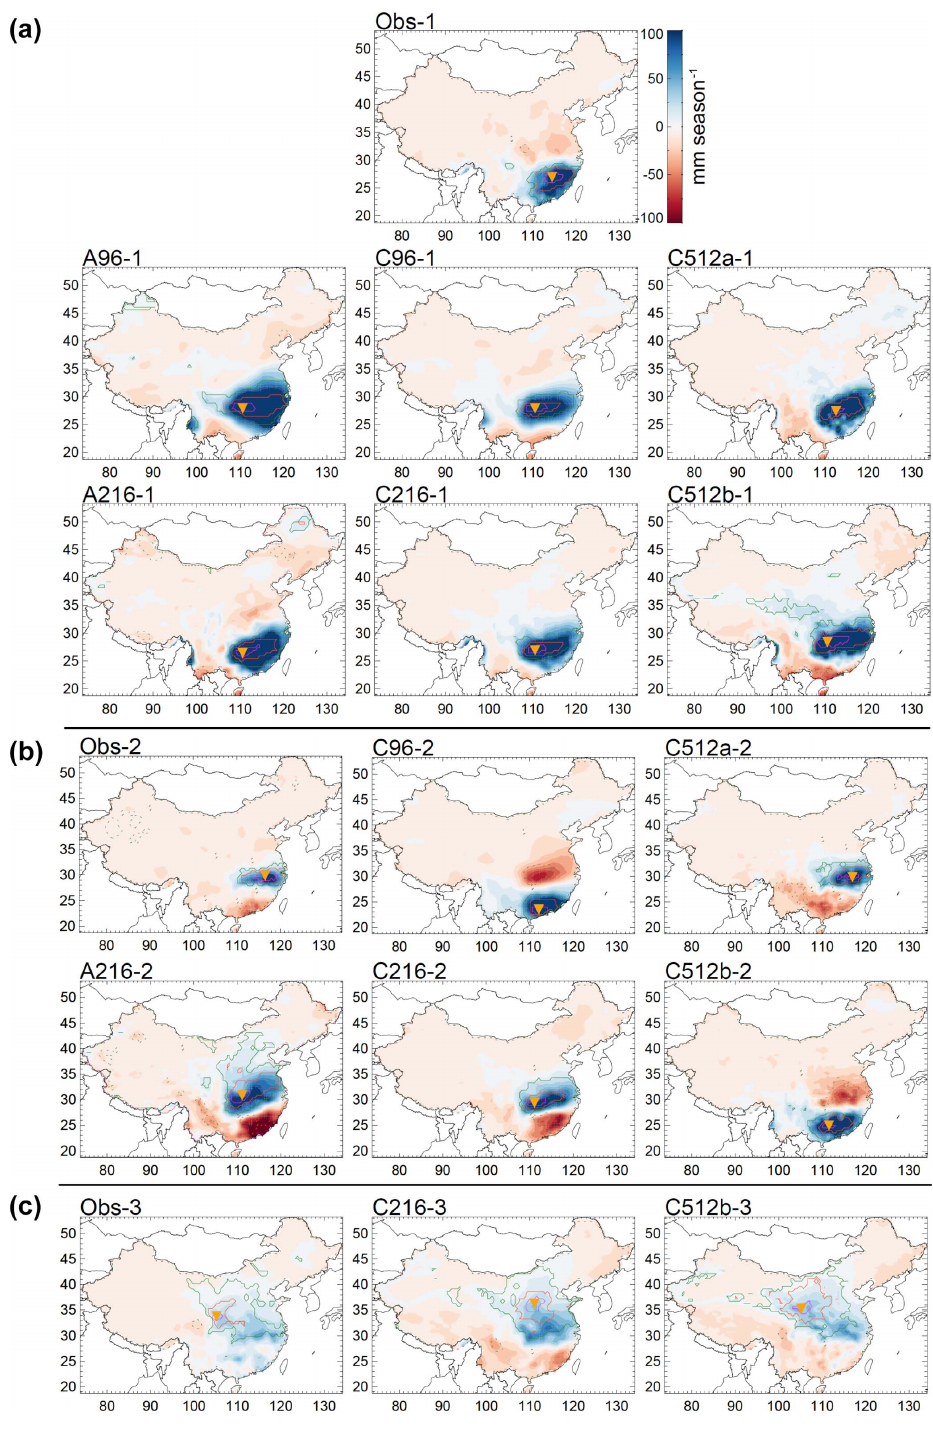
Figure 8. Shading shows regressions of MAM precipitation against observed or simulated EOT time series that have a linear correlation co- efficient exceeding 0.38 with Obs-1 (a) , Obs-2 (b) or Obs-3 (c) . Also shown are positive (solid lines) and negative (dashed lines) correlations of the full (leading-order) or residual (higher-order) precipitation-anomaly time series with the EOT base point exceeding 0.8 (magenta), 0.6 (orange) and 0.4 (green). The EOT base point is marked by the orange inverted triangle. The number next to the simulation name above each panel indicates the order of the simulated EOT